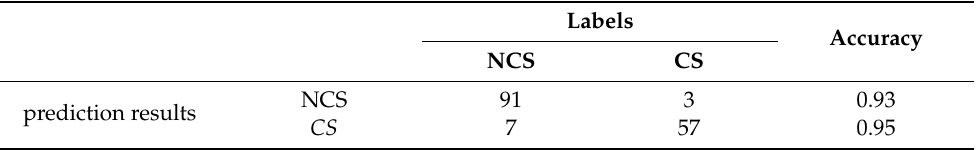
Table 15. Results of predicting the coping skills of older drivers based on behavior in preparing to start the car using random